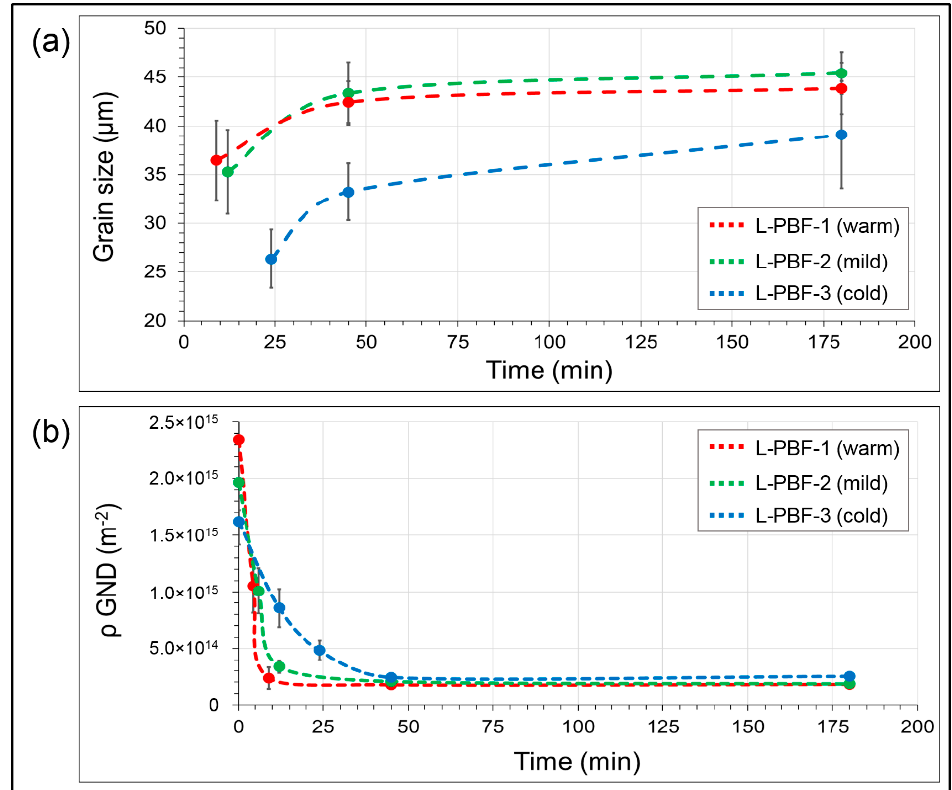
Figure 16. ( a ) Grain size (equivalent diameter) and ( b ) GND density versus heat treatment duration at 1100 °C for the three L-PBF conditions. Shorter recrystallization times (9 min) were obtained for the warmer condition (L-PBF-1).